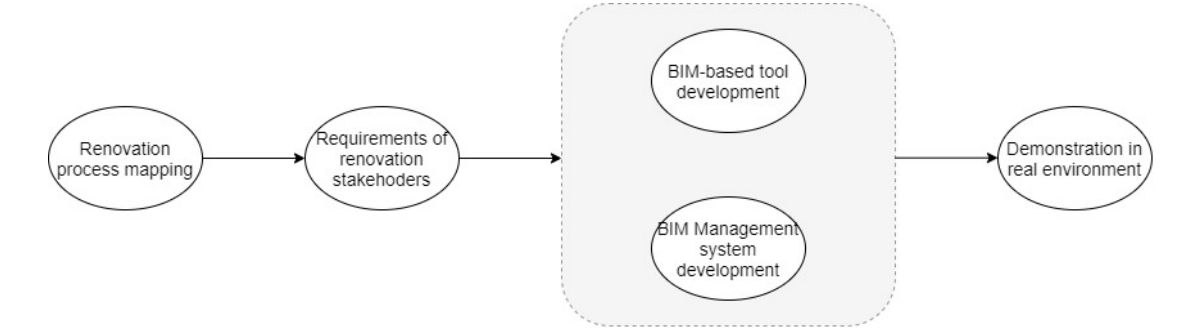
Figure 1. Research methodology.